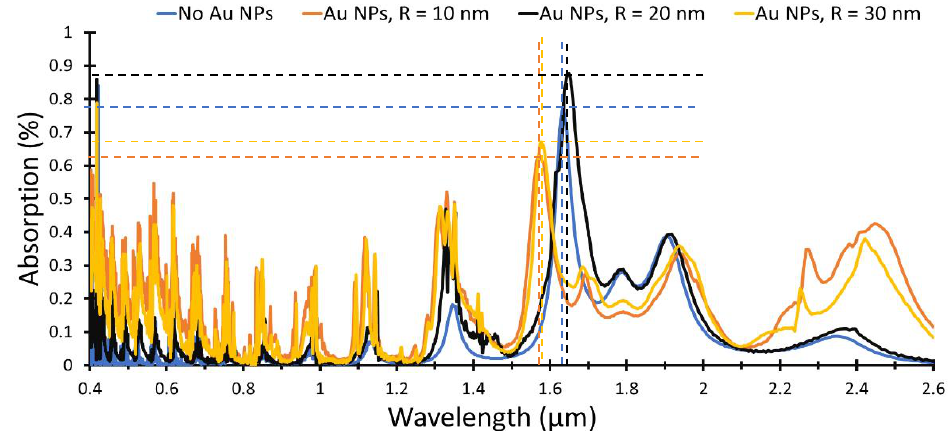
Figure 10. Absorbance of the proposed bent ZnO NWs without and with Au NPs of radius 10, 20 and 30 nm, respectively, distributed on the top of the ZnO base layer.